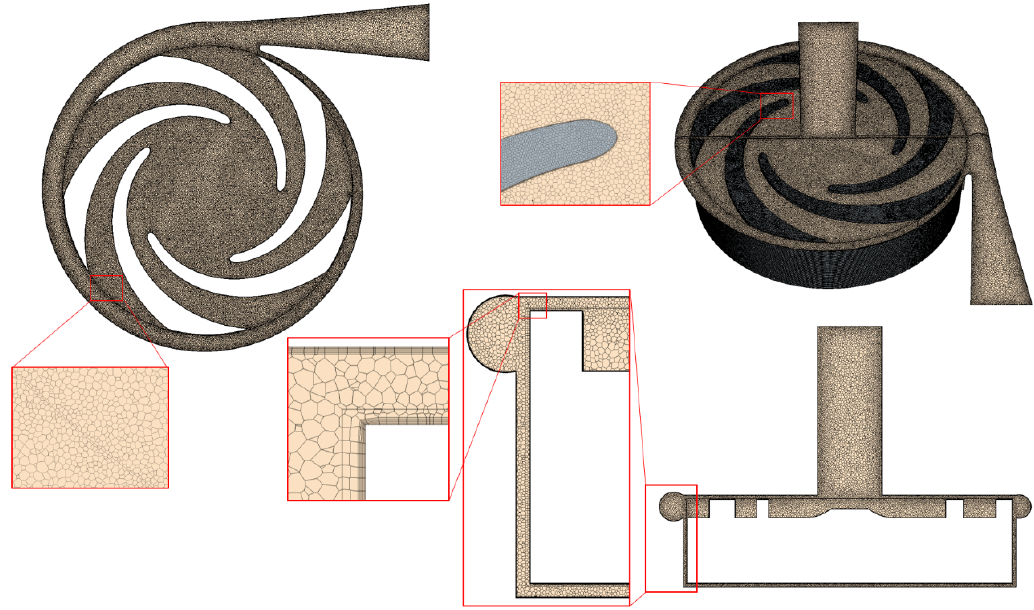
Figure 5. Mesh distribution on the fl uid volume of the pump with the impeller of SH1.